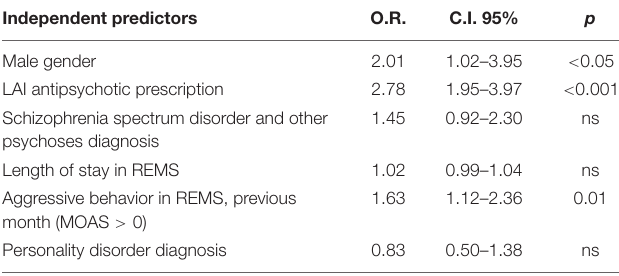
TABLE 3 | Binary logistic regression analysis of factors associated with high-dose antipsychotics prescription [prescribed daily dose (PDD)/defined daily dose (DDD) > 1.5].